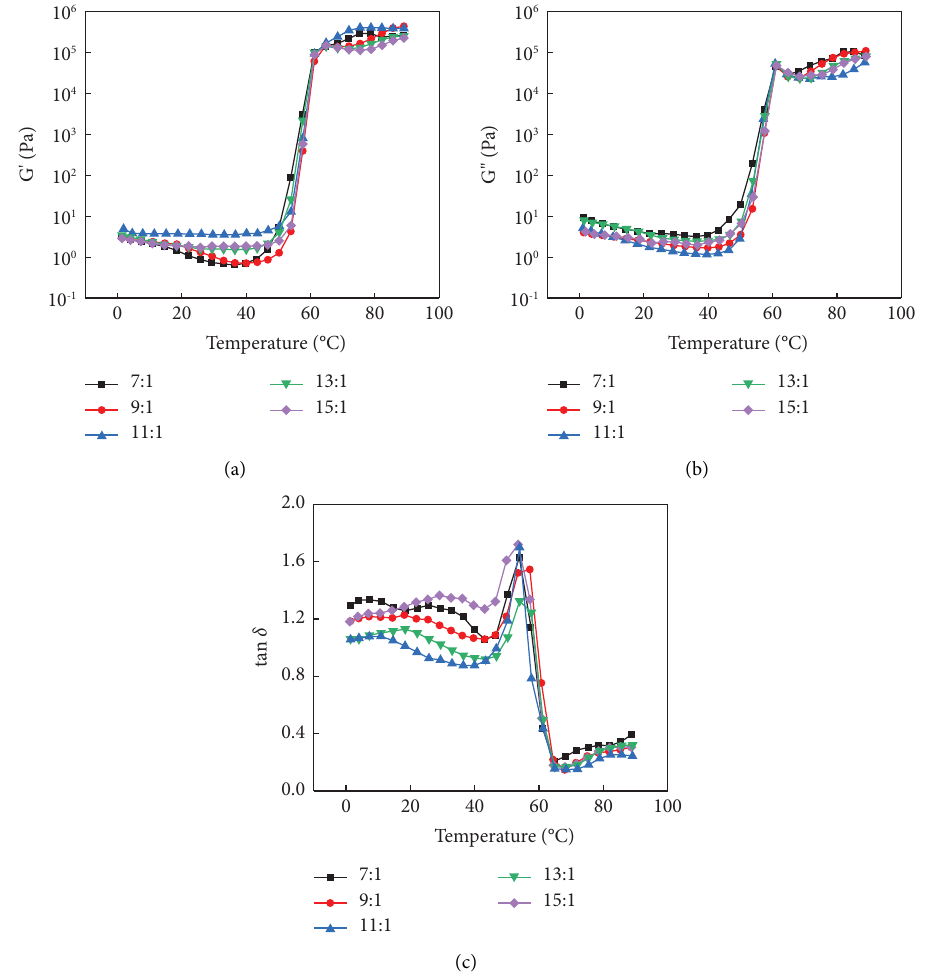
Figure 2: Efect of the WS :WG ratios on the rheological behavior of the batter. (a), (b), and (c) represent the storage modulus ( G ′ ), the loss modulus ( G ″ ), and the loss tangent (tan δ ), respectively. Values of the WS :WG ratio (w/w) are given in the